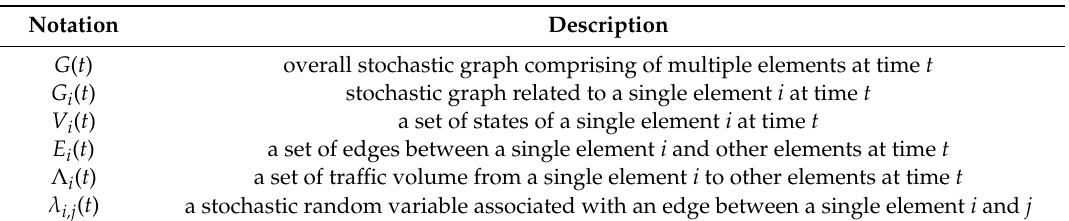
Table 2. Notation of the graph model